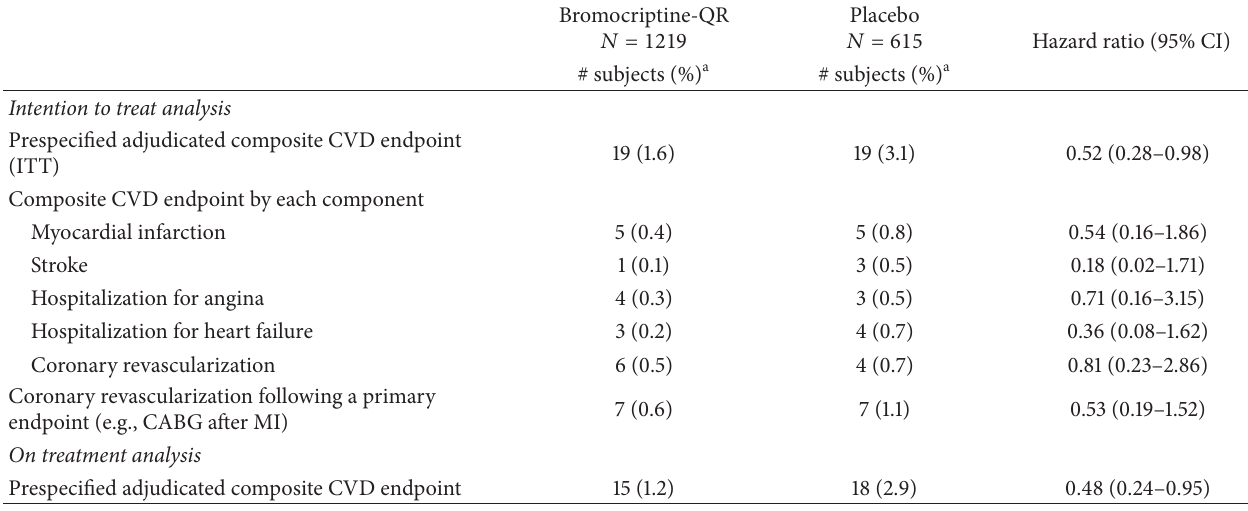
Table 2: Impact of bromocriptine-QR on a prespecified, adjudicated composite CVD endpoint, and individual components of the